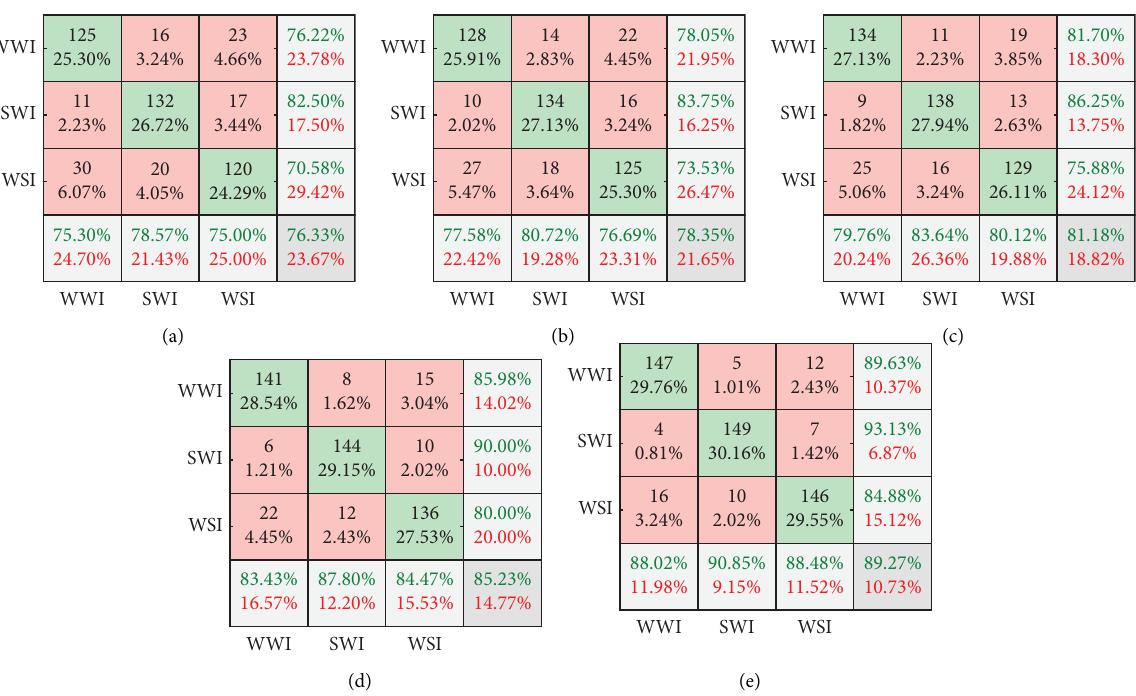
Figure 18: Confusion matrix at 1s before crossing the zebra crossing: the cyan color indicates the number of correct recognitions and their proportion in all samples, and the light red color indicates the number of misrecognitions and their proportion in all samples. Te rightmost column in the fgure is precision, and the bottom column is recall. (a) Confusion matrix of SVM; (b) confusion matrix of LSTM; (c) confusion matrix of AT-Bi-LSTM; (d) confusion matrix of